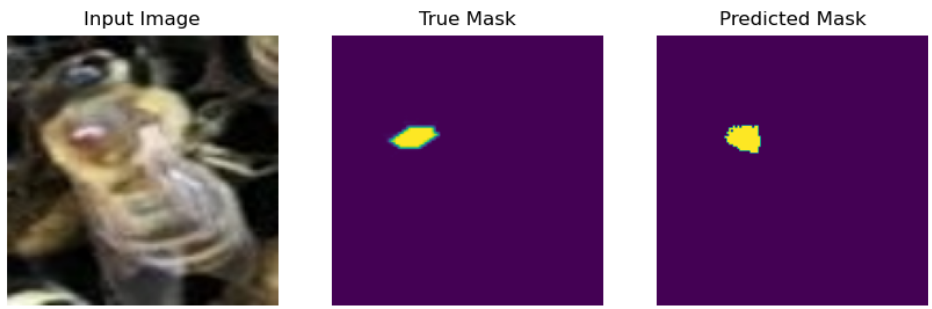
Figure 5. Detected bees by Faster RCNN. Coloured bounding boxes are predicted objects and white bounding boxes are ground-truth objects.